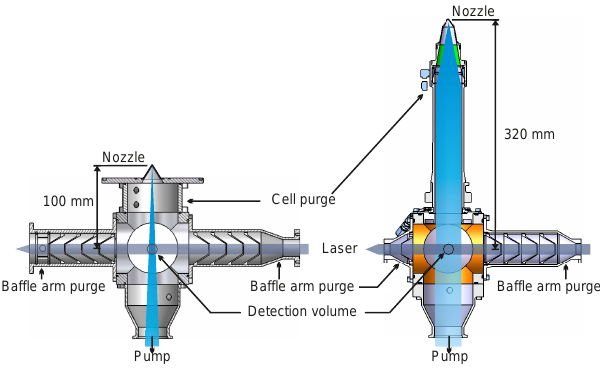
Figure 1. The two cell designs for OH detection by LIF for ground- based measurements (left) and measurements on an aircraft, which requires a longer inlet (right). The estimated residence time for the detection cell with the short inlet is 1.6ms, much shorter compared to the cell with the long inlet (approximately 30ms). Windows are placed where the laser enters and exits the fluorescence